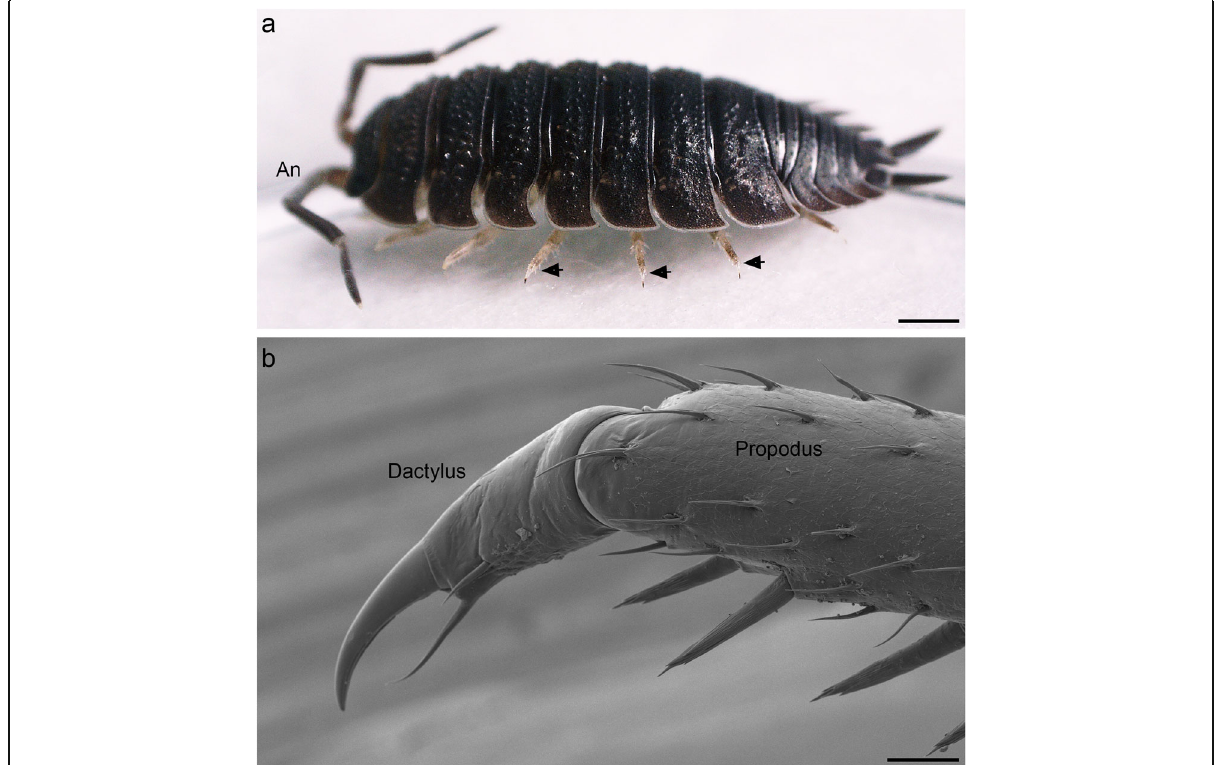
Fig. 1 Woodlouse Porcellio scaber and its propodus-dactylus joints. a Photograph of a specimen of P. scaber . The isopod is approximately 10 mm long and stands on the tips of its dactyli. Arrows mark the joints between the propodi and the dactyli of three pereopods. b Posterior view of a P. scaber pereopod, showing the joint between the propodus and the dactylus. Scale bars: 1 mm (a), 50 μ m